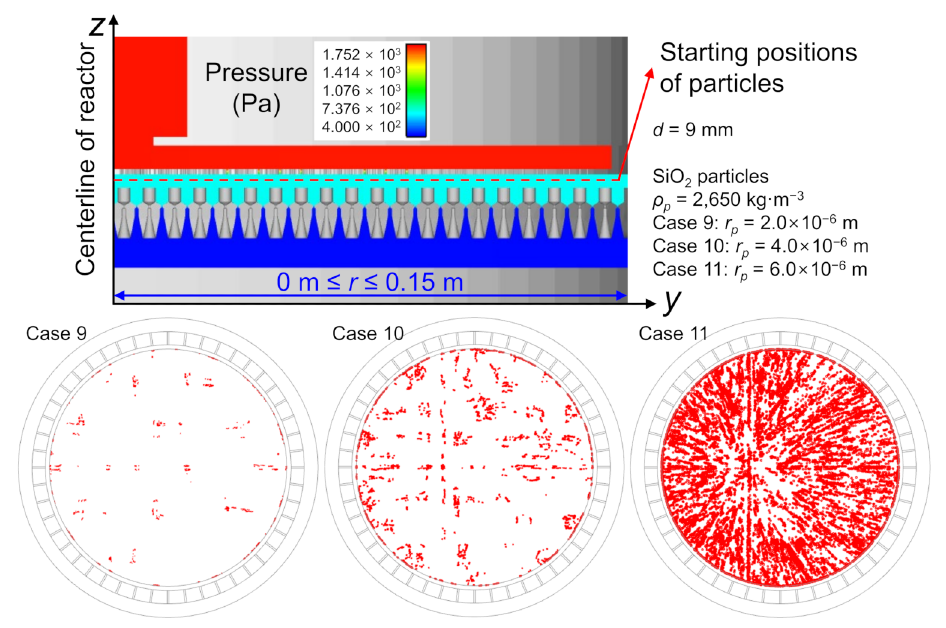
Figure 6. Starting positions of inertial particles are indicated. The spatial variation in the gas pressure ( p g , Pa) is plotted together for Case 3. Final positions of particles deposited on the heater surface depicted for Case 9 ( r p = 2.0 × 10 − 6 m, ρ p = 2650 kg · m − 3 , d = 9 mm), Case 10 ( r p = 4.0 × 10 − 6 m, ρ p = 2650 kg · m − 3 , d = 9 mm), and Case 11 ( r p = 6.0 × 10 − 6 m, ρ p = 2650 kg · m − 3 , d = 9